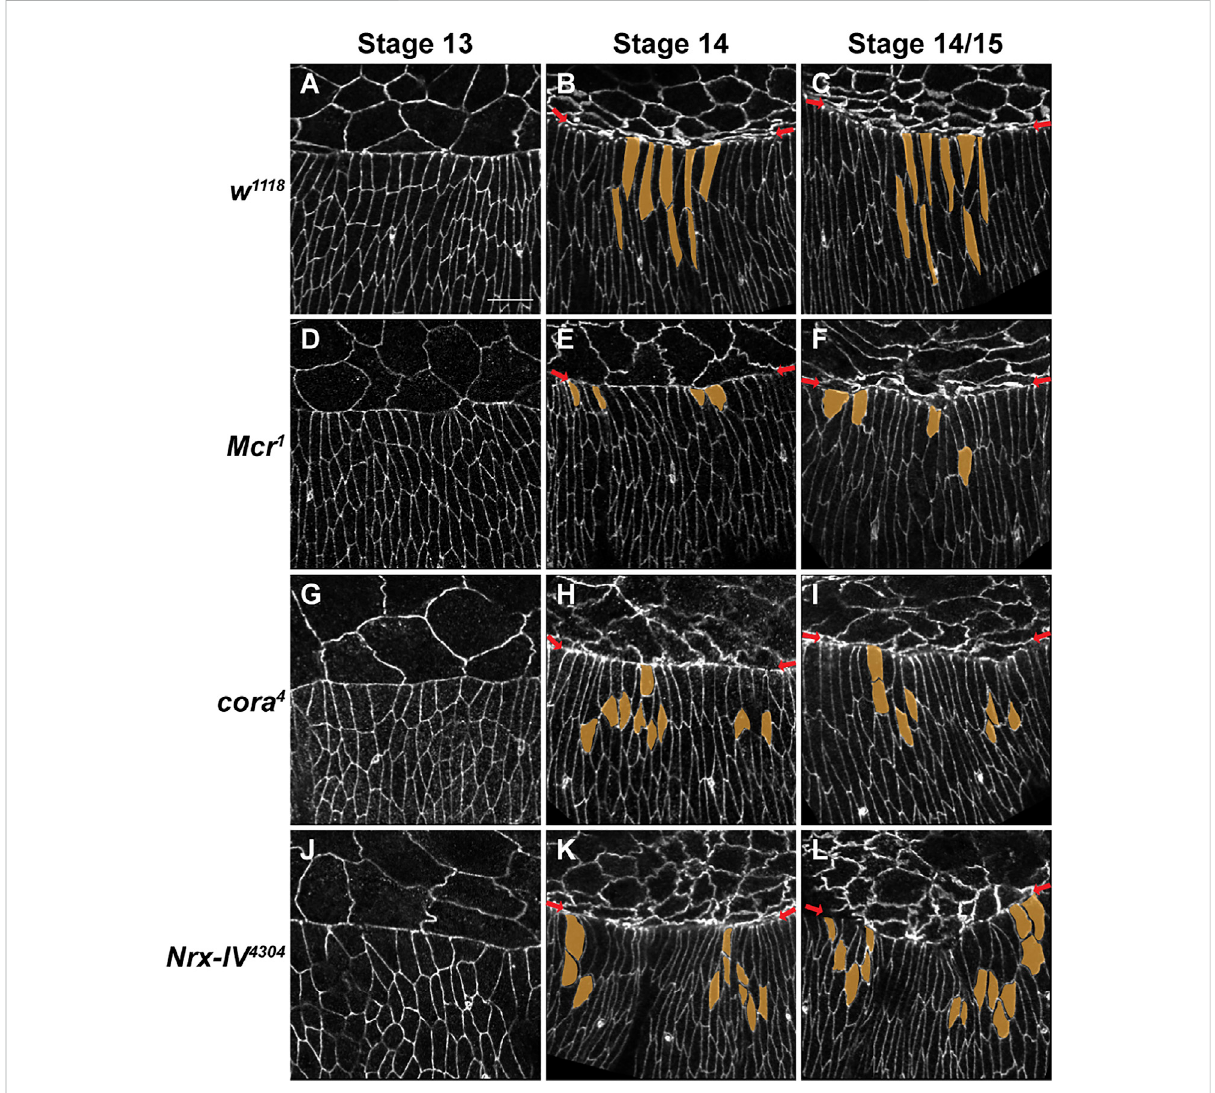
FIGURE 2 SJ mutants have defects in epidermal cell shape and organization of the leading-edge during later stages in closure. (A – L) Confocal optical sections of stage 13, 14 and 14-15 wild type, Mcr , cora 4 and Nrx-IV 4304 embryos stained with an antibody against E-cadherin. ( A – C) During closure in wild type embryos, DME cells along the leading edge (red arrows) smoothen into a neatly organized row of cells that is elongated along the dorsoventral axis. The row of cells immediately ventral to the DME also elongate dorsoventrally. (D,G,J) DME cells in stage 13 SJ mutant embryos elongate along the dorsoventral axis and show only mild defects in the lateral epidermis. (E,H,K) In stage 14 SJ mutant embryos, groups of lateral epidermal cells fail to elongate to the same extent as wild type (segmented in yellow). (F,I,L) The leading edge in stage 14-15 SJ mutant embryos is irregular (red arrows). Groups of cells at the leading edge and following row exhibit defects in elongation. These cells appear more constricted or wider (segmented in yellow). Representative DME and second row cells are pseudocolored in yellow. Scale bar = 10